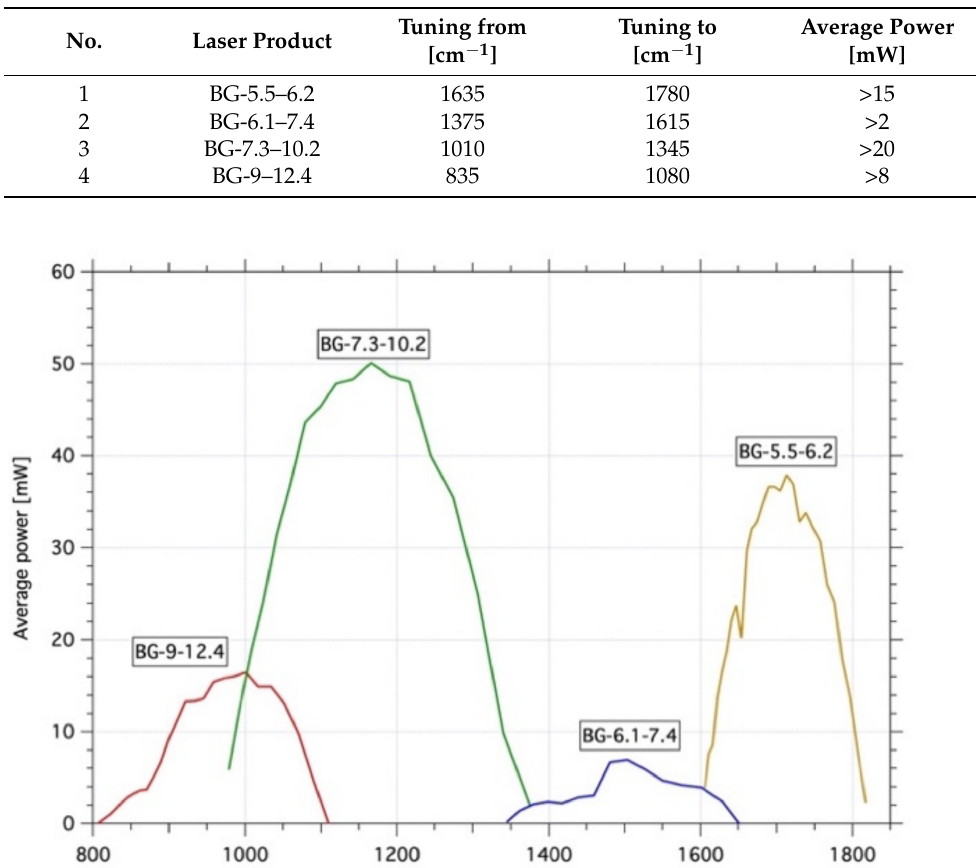
Table 2. Laser selection for the PHOOTONICS active illuminator.